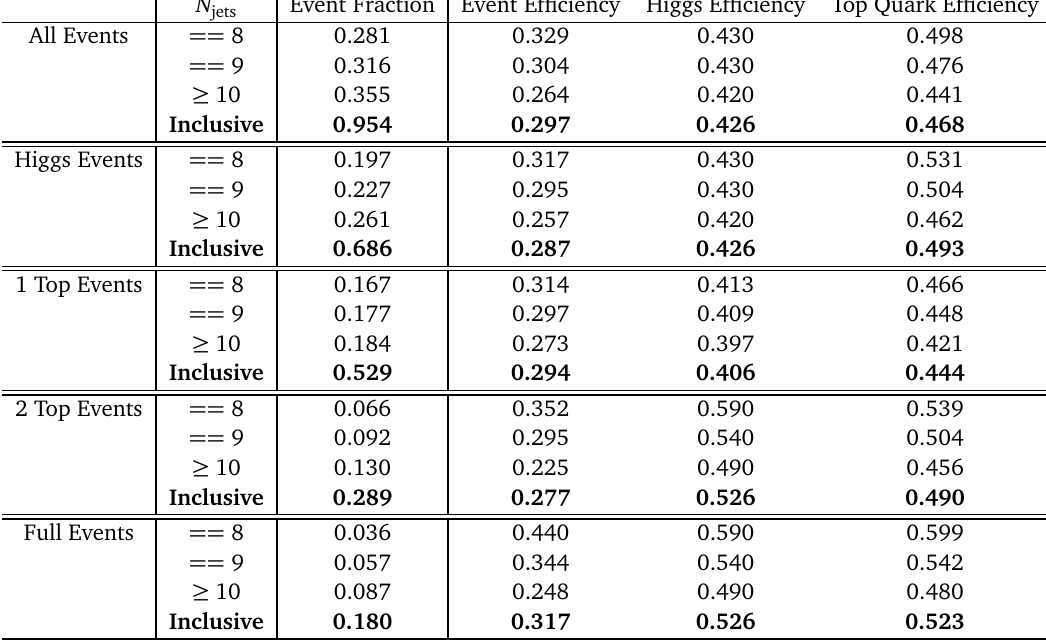
Table 10: S PA -N ET results on t ¯ tH with at least 2 b -tagged jets (all generated events).